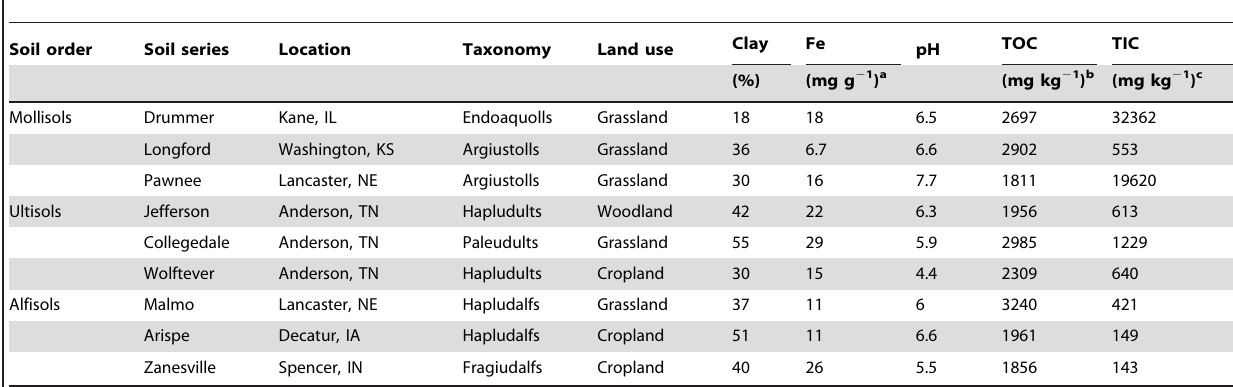
Table 1. General characteristics of